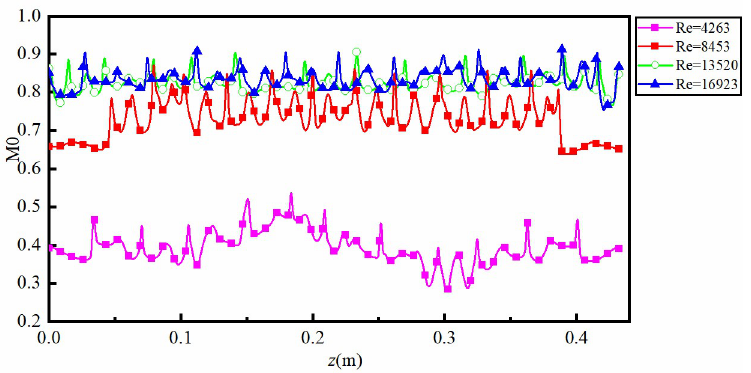
Figure 11. Axial distribution of M 0 in the middle position of the inner and outer cylinders. Re = 4363 (case 4 in Table 1), Re = 8453 (case 5), Re = 13,520 (case 1), Re = 16,923 (case 6).